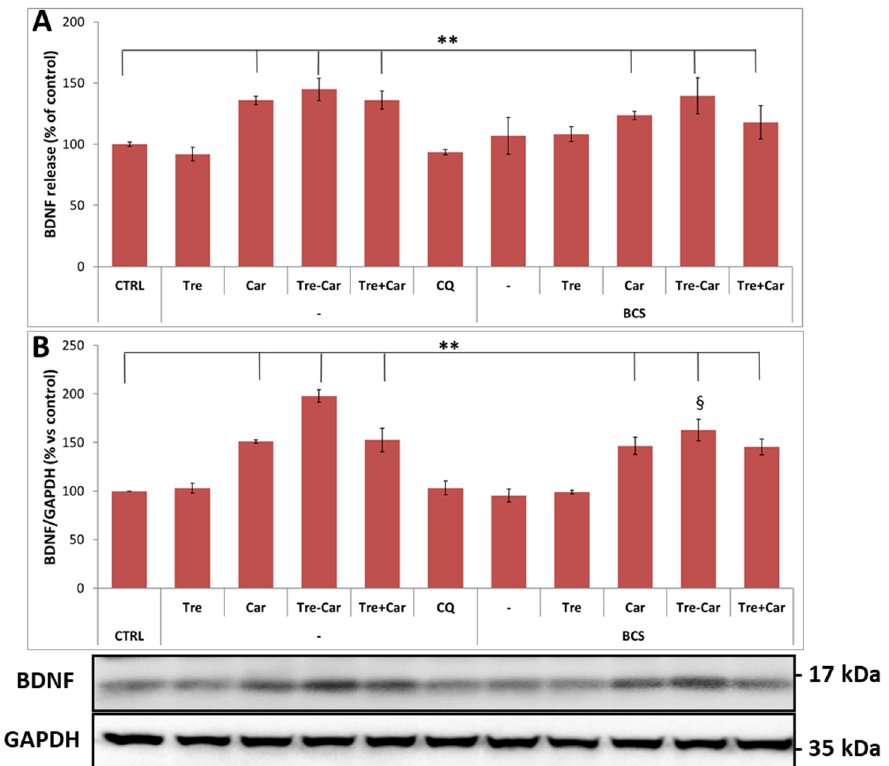
Figure 8. BDNF secretion ( A ) and expression ( B ) increases after treatment with Car and Tre-Car. Starved PC12 cells were stimulated by 5 mM Tre, Car, Tre-Car and Tre + Car mixture or 10 µ M CQ for 24 h in RPMI-1640 complete medium with 1% of FBS, with or without 50 µ M BCS. Cell culture mediums were collected and analyzed by ELISA BDNF kit ( A ). The expression level of BDNF was analyzed by western blotting ( B ). (** p ≤ 0.01 versus control untreated cells; § p ≤ 0.05 vs. Tre-Car treatment). Dashes to the right of the membrane bands show positions of prestained molecular mass marker.